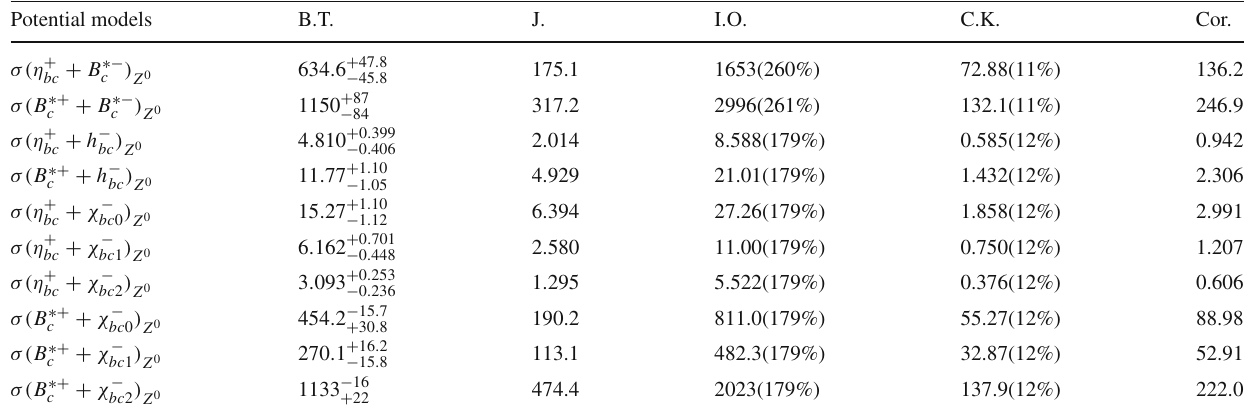
Table 6 Uncertainties of the total cross sections (units: × 10 − 3 f b ) caused by constituent quark masses under B.T. model, and by four other potential models for Z 0 propagated channels of the double B c